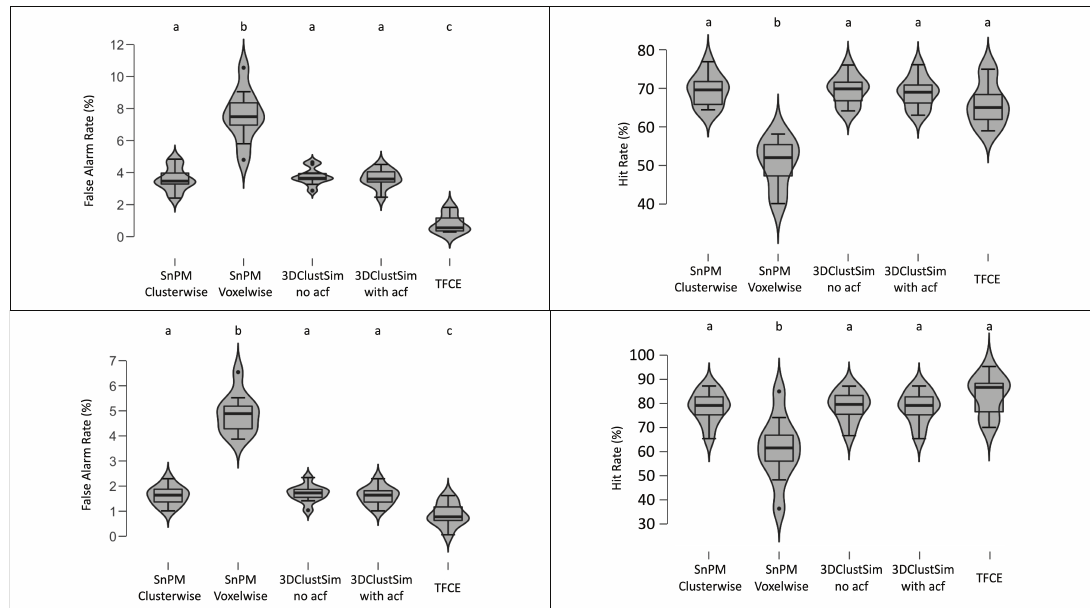
Figure 1. Violin plots of calculated false alarm and hit rates in five different conditions. ( Top-left ) Moral psychology fMRI false alarm rate. ( Top-right ) Moral psychology fMRI hit rate. ( Bottom-left ) Working memory fMRI false alarm rate. (Bottom-right) Working memory fMRI hit rate.